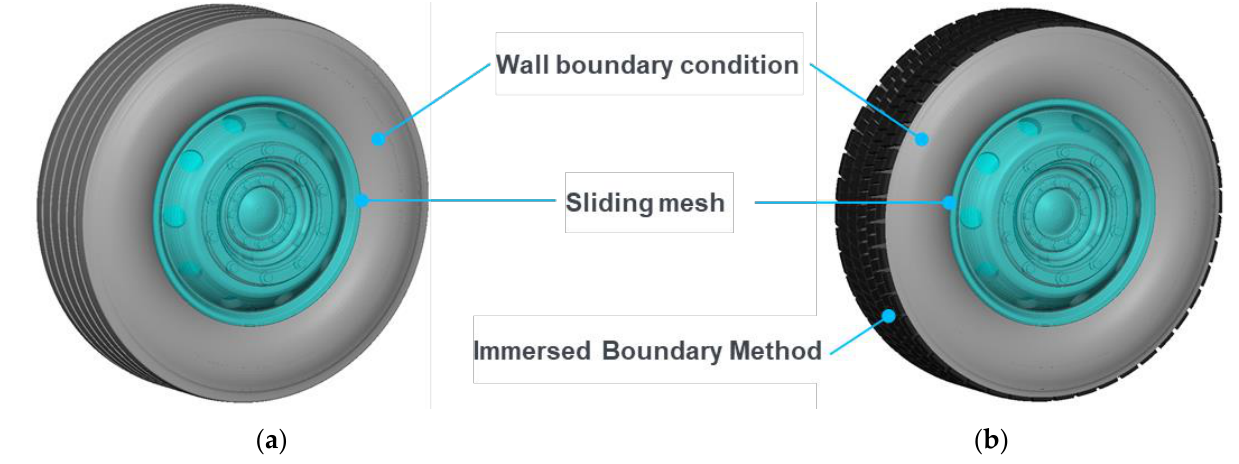
Figure 7. CFD modeling of wheel rotation: ( a ) Front wheel with longitudinal grooves; ( b ) Front wheel with treaded pattern.